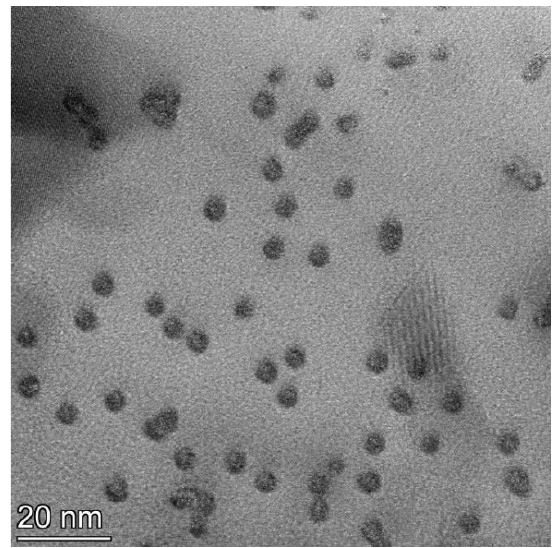
Figure 1. BF TEM image of n-Si 3 N 4 irradiated with 670 MeV MeV Bi ions. The dependence of average track radius on electronic stopping powers, S e , calculated with SRIM-2016, is shown in Figures 2 and 3. To modulate the stopping power, Al, degrader foils of varying thicknesses were used, except at the highest stopping power, where no foil was used. The degrader foil introduced a dispersion in the stopping power that increased with foil thickness. The dispersion for native stopping powers (no foil) was too small to be visible in Figure 2.